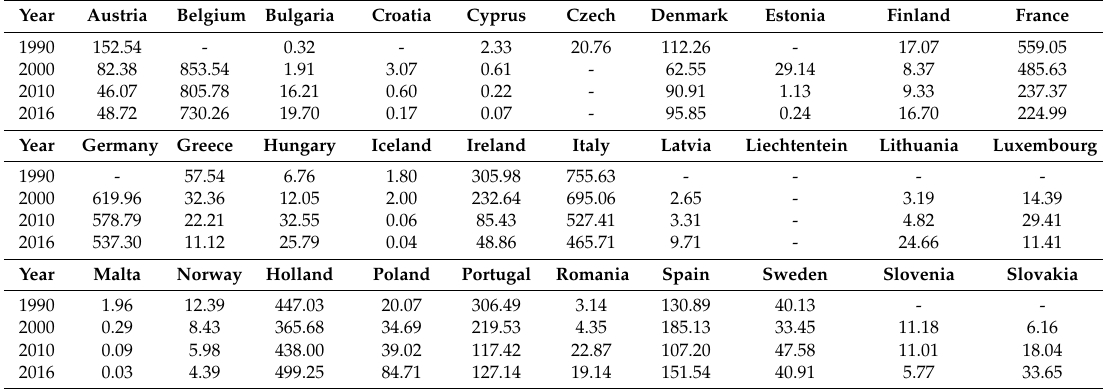
Table 4. Values of UK textile materials imports from EEA members (unit: dollars in millions).